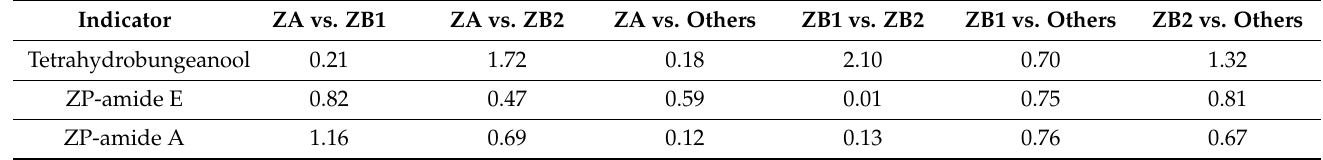
Table 1. Variables important in projection and verification by permutation test between different prickly ash groups. Indicator ZA vs. ZB1 ZA vs. ZB2 ZA vs. Others ZB1 vs. ZB2 ZB1 vs. Others ZB2 vs. Others Tetrahydrobungeanool